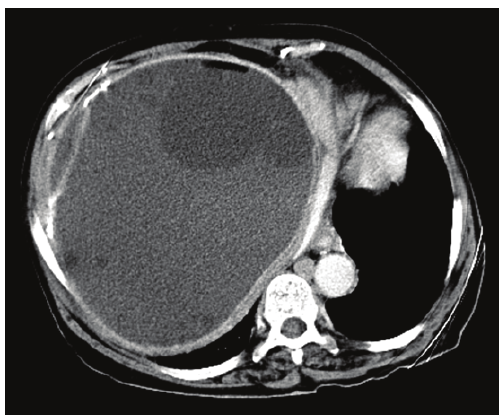
Figure 1: CT image of the thick-walled, complicated multicystic lesion and air density in it with a dimension of 19cm × 19cm ×